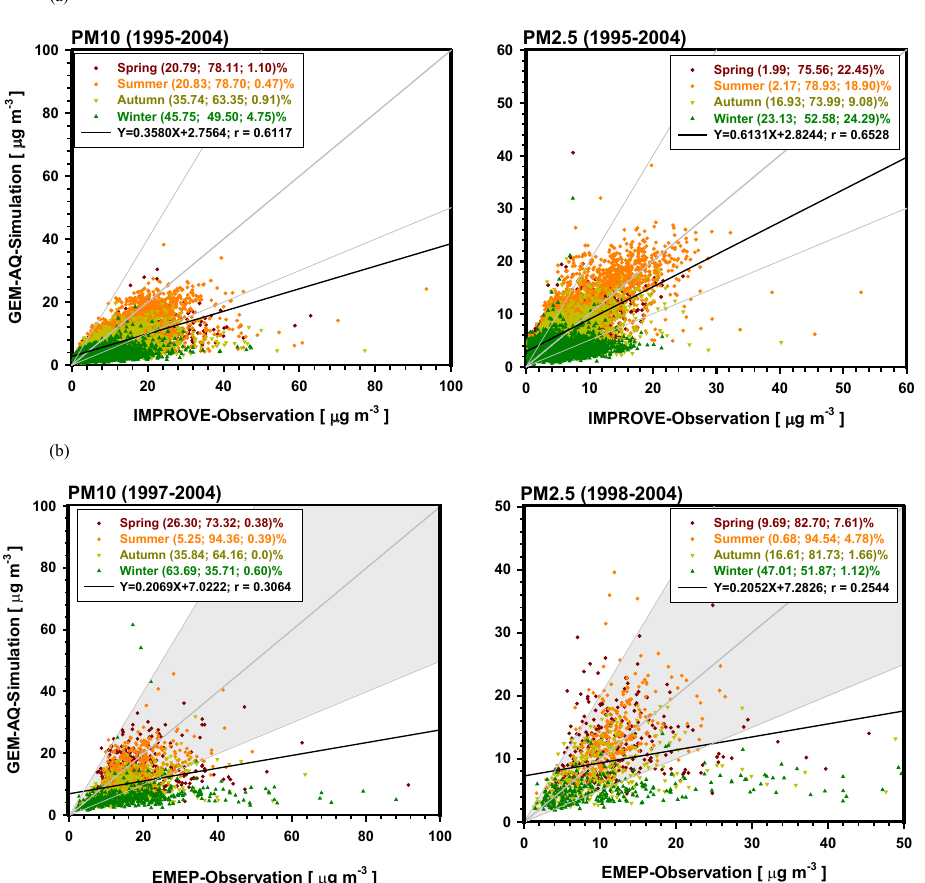
Fig. 8. Correlations of seasonally averaged PM 10 and PM 2 . 5 with network observations in (a) North America and (b) Europe. Legend explanations are given the same as in Fig.